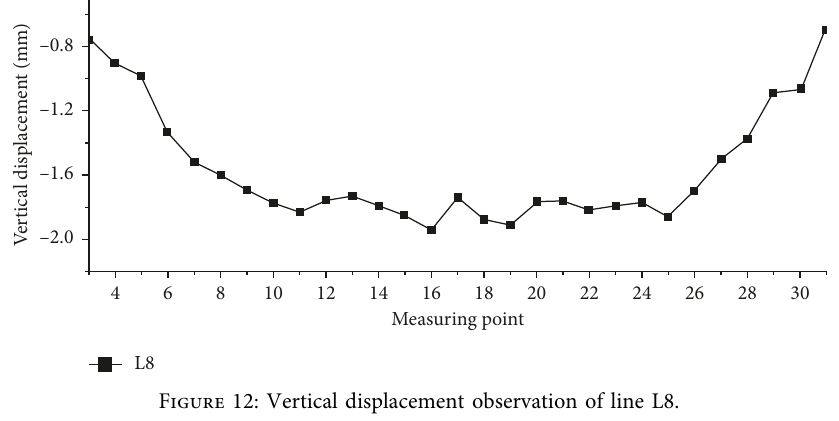
Figure 12: Vertical displacement observation of line L8.